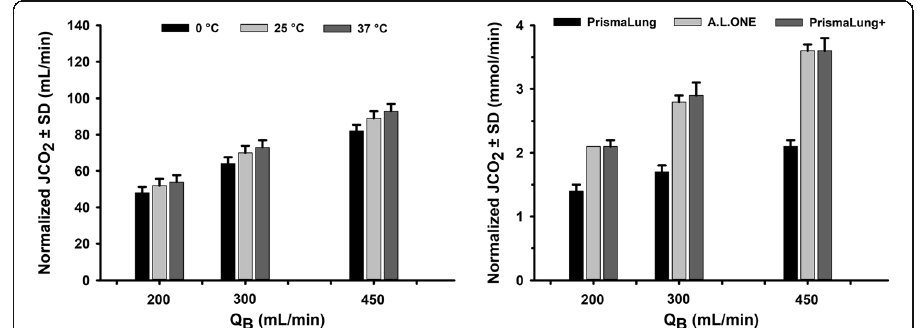
Fig. 3 CO 2 removal performance as a function of temperature. Assessed using the infusion method for a PrismaLung+ at a